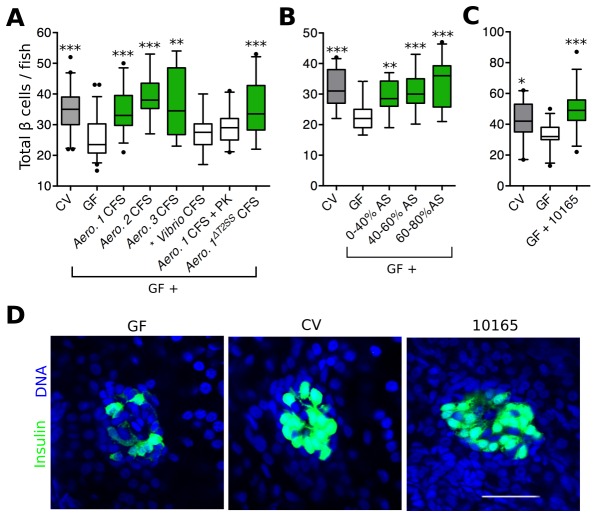
Aeromonas secretes a factor that rescues normal expansion of the GF β cell mass.(A) Total β cell numbers in GF, CV and GF fish treated at 4 dpf with different cell free supernatant (CFS) samples. 'Aero.' refers to bacteria of the genus Aeromonas, with each number (1, 2, 3) denoting a separate species. '+ PK' indicates proteinase K addition to the CFS sample prior to treatment. *p<0.05, **p<0.01, ***p<0.001: Denotes treatment that is significantly different than GF by Tukey analysis. (B) Total β cell numbers in CV, GF and GF fish treated at 4 dpf with separate ammonium sulfate fractions (% AS) prepared from the Aeromonas 1ΔT2SS CFS. Note that the 60–80% ammonium sulfate fraction resulted in the greatest increase in β cell numbers. (C) Total β cells in GF, CV and GF fish treated with purified protein. 10165 represents purified protein from the M001_10165 locus. (D) Representative 2D slices from confocal scans through the primary islets of GF, CV and 10165 protein treated Tg(-1.0insulin:eGFP) 6 dpf larvae. Insulin promoter expressing β cells are shown in green and nuclei are blue. Scale bar = 40 μM.DOI:
http://dx.doi.org/10.7554/eLife.20145.00810.7554/eLife.20145.009Figure 3—source data 1.Quantifications and statistical analysis of larval β cells corresponding to Figures 3A.Exact values of N, mean, median, SD, and SEM are reported in the source data file and are highlighted in yellow, magenta, blue, green, and cyan, respectively.DOI:
http://dx.doi.org/10.7554/eLife.20145.00910.7554/eLife.20145.010Figure 3—source data 2.Quantifications and statistical analysis of larval β cells corresponding to Figure 3B.DOI:
http://dx.doi.org/10.7554/eLife.20145.01010.7554/eLife.20145.011Figure 3—source data 3.Quantifications and statistical analysis of larval β cells corresponding to Figure 3C.